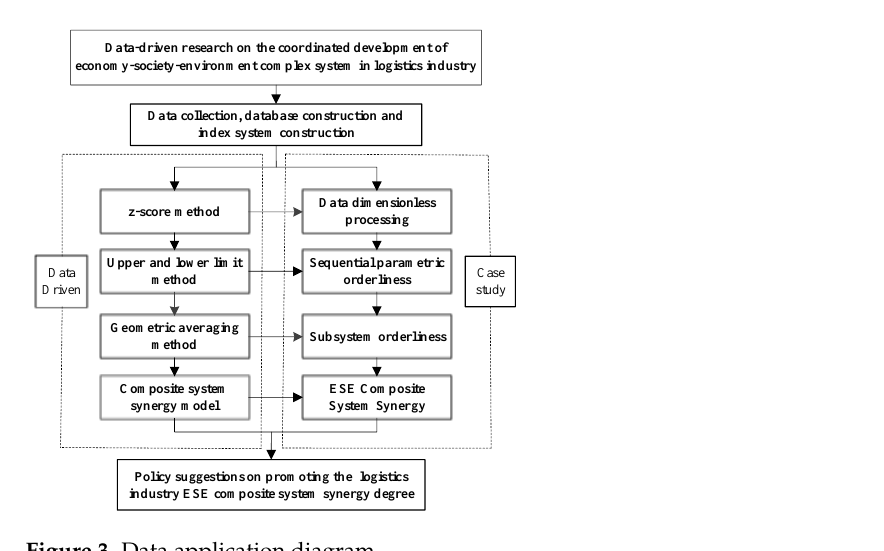
Figure 3. Data application diagram.